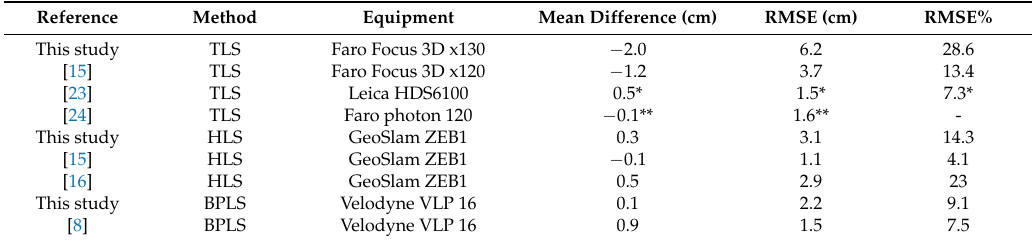
Table 8. Comparison of current results with previous studies derived from the terrestrial laser scanner (TLS), handheld laser scanner (HLS) and the backpack laser scanner (BPLS). * mean value calculated from Liang and Hyyppä [23]. ** single scan, Lemen algorithm, beech plot